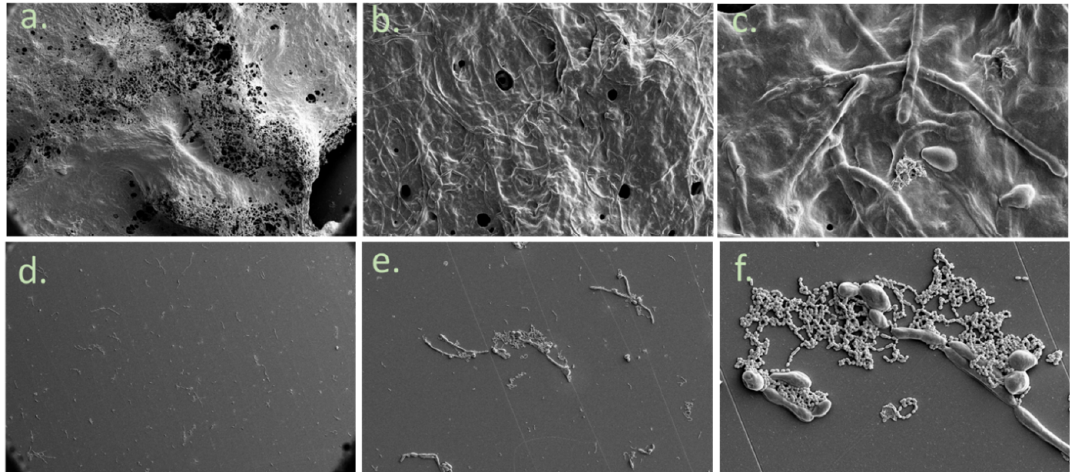
Figure 4. Biofilm morphology on orthodontic PVC using SEM. Morphology of the biofilm using SEM. ( a ) Control group at ×200 magnification. ( b ) at ×1000. ( c ) at ×5000. ( d ) PPFGT- & PH-treated C. albicans and S. mutans at ×200 magnification. ( e ) at ×1000. ( f ) at ×5000.